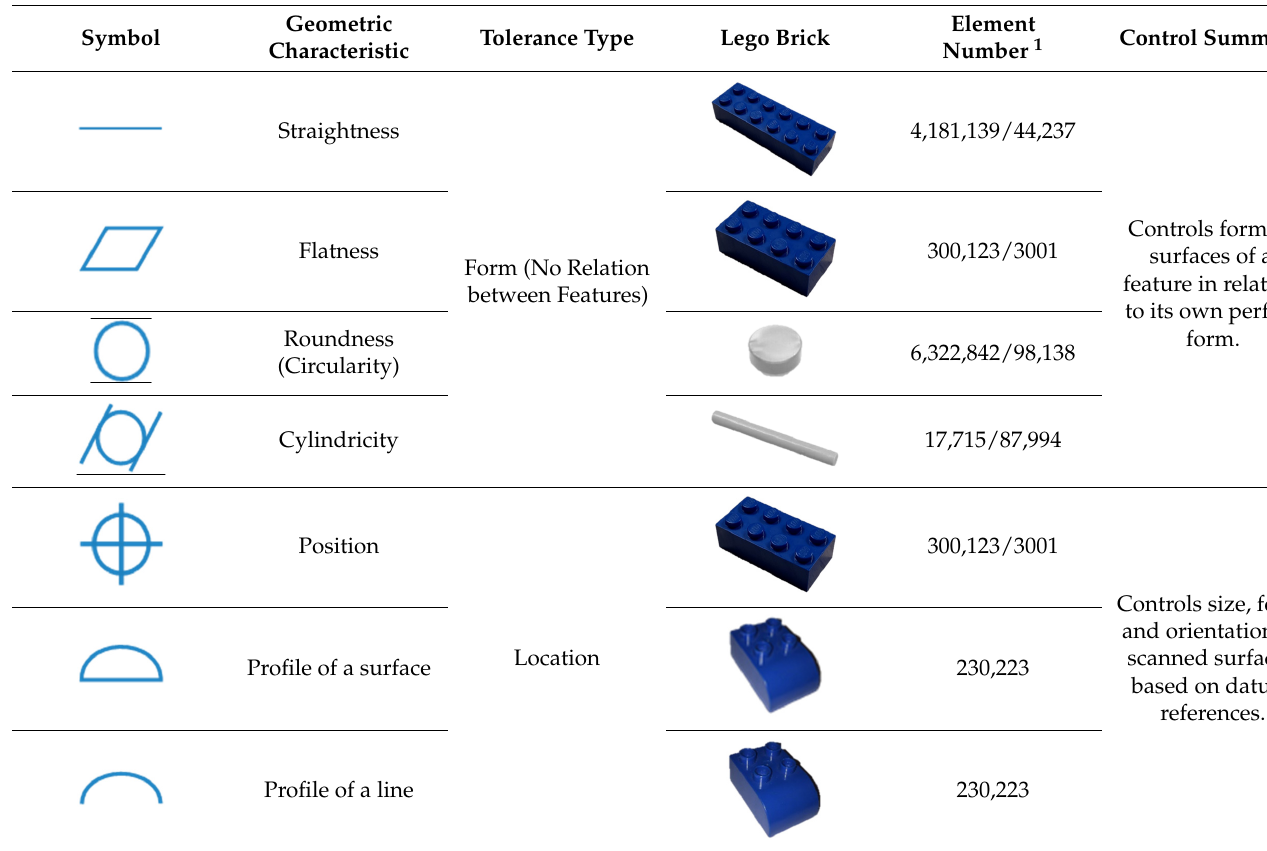
Table 1. Overview of the used Lego bricks for the inspection of geometric characteristics and tolerances [19]. Evaluation of Scanned Lego Bricks by Shape Tolerances According to DIN EN ISO 1101 Symbol Geometric Characteristic Tolerance Type